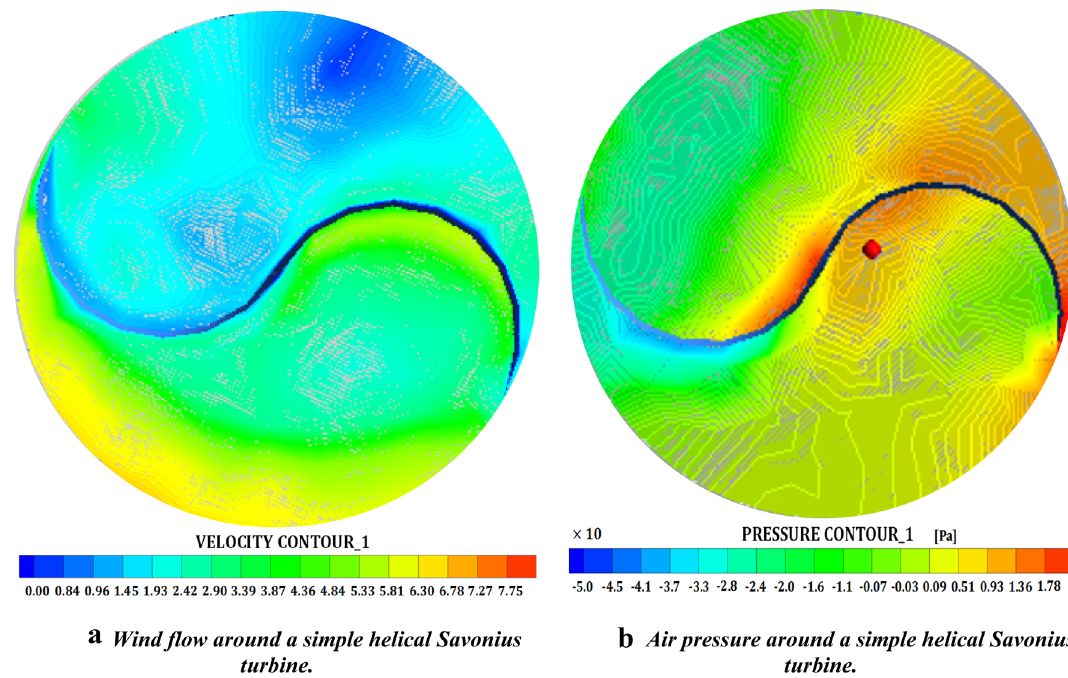
Fig. 6 a Wind flow around a simple helical Savonius turbine; b Air pressure around a simple helical Savonius